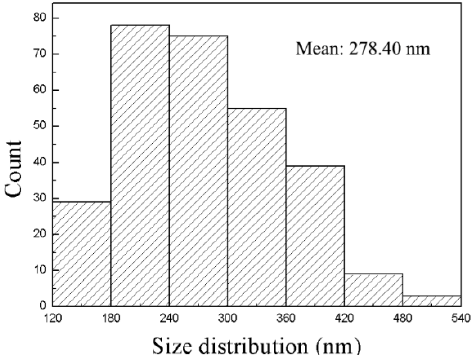
Figure 3. Distribution of D hk0 of the Ni(OH) 2 nanoplates over 288 nanoplates.